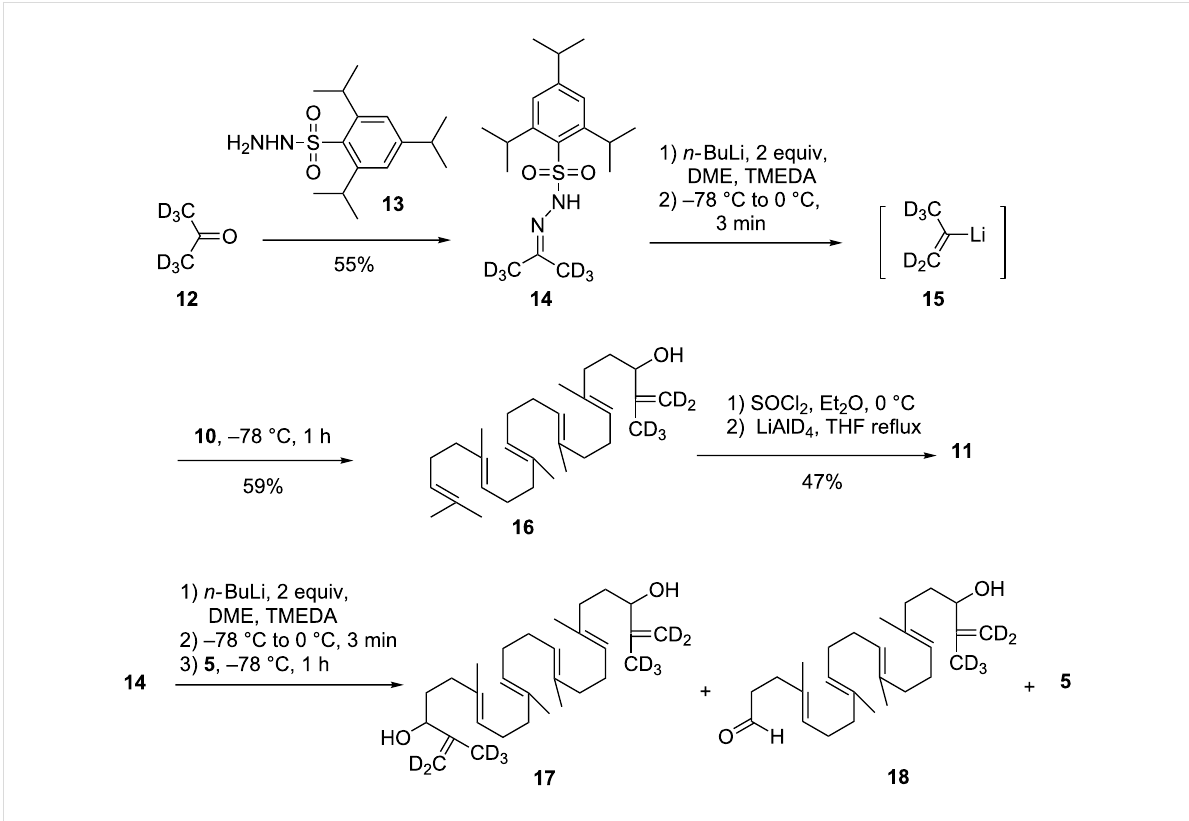
Scheme 2: Implementation of the deuterated isopropylidene end-group by the Shapiro reaction of trisylhydrazone of acetone- d 6